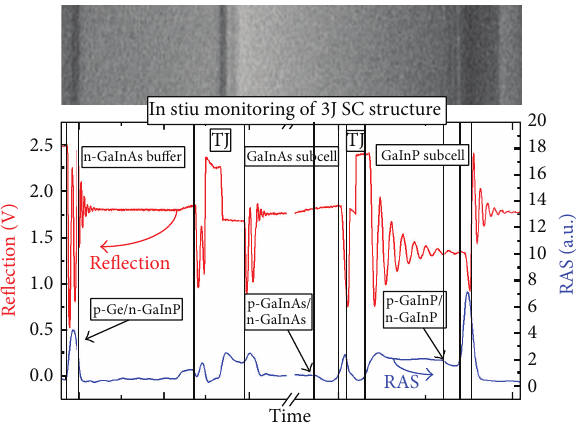
Figure 2: Approach of the in situ control of MJ SC parameters (layer thicknesses, solid solution composition, doping levels and homoint- erfacedetection,heterointerfacequality,etc.)basedonsimultaneous measurements of the time dependencies of short-wavelength (on 3.8 eV) RA and long-wavelength (on 2.1 eV) reflection signals (lower part) and SEM image of cross-section of GaInP/GaInAs/Ge MJ